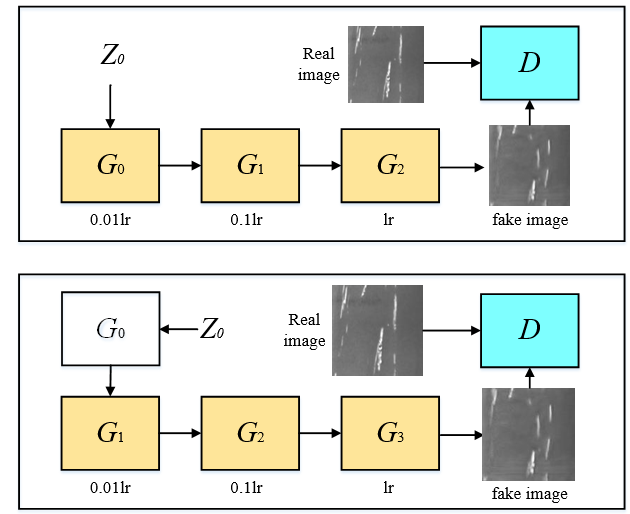
Figure 4. Multi-stage training structure with di ff erent learning rates.